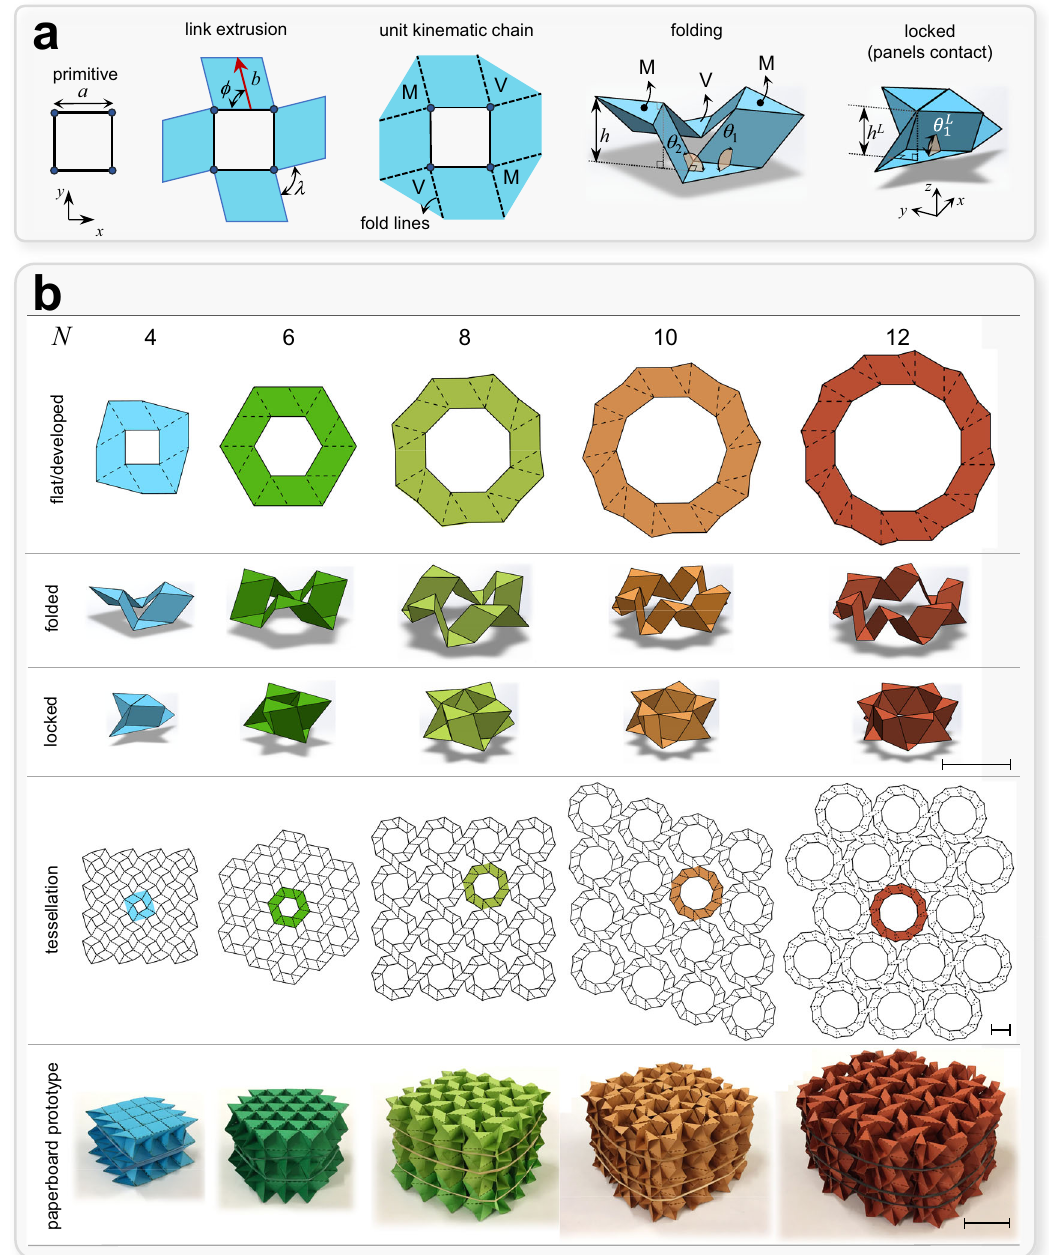
Fig. 1 Conceptual scheme to generate self-locking kinematic chains and tessellations along with their paperboard prototypes. a The building block of our recon fi gurable class of rigidly fl at-foldable materials. Primitive regular polygon describing a four-bar linkage, followed by in-plane angled ( ϕ ) extrusion (red arrow of length b ) of constitutive links; connection of extruded panels with isosceles triangular panels; addition of fold lines and assignment of a mountain (M) and valley (V). Upon folding, the unit chain recon fi gures to reach its lock state (speci fi ed with “ L ” ) where contact is established between panels. b Concept abstraction to generate unit chains with an N even-sided regular polygon for representative N , i.e., 4, 6, 8, 10, and 12. The fi rst three rows show respectively the developed, partially folded, and one of the (multiple) lock states. The last two rows show the in-plane tessellation and their paperboard proof-of-concepts. The latter are multilayered spatial realizations obtained with the minimum number of layers, i.e., an even number of layers preserving their symmetry with respect to x-y plane, that provides one degree of freedom. Rubber bands are here used to hold the unloaded con fi guration of the prototypes in their lock state, as the transition to the lock state requires the application of compressive forces in the x - y plane, as explained later in the manuscript. Scale bars = 30 (cid:1) focus on a subset (Fig. 1b), namely the subclass de fi ned by b ¼ 1 ð 1 ; π = 3 Þ denoted hereafter as b N and ϕ ¼ π = 3, i.e., N for N N simplicity, with N = 4, 6, 8, 10 and 12, and we refer to the more whenever our analysis become independent of general case N N (cid:1) the two geometric parameters b and ϕ .